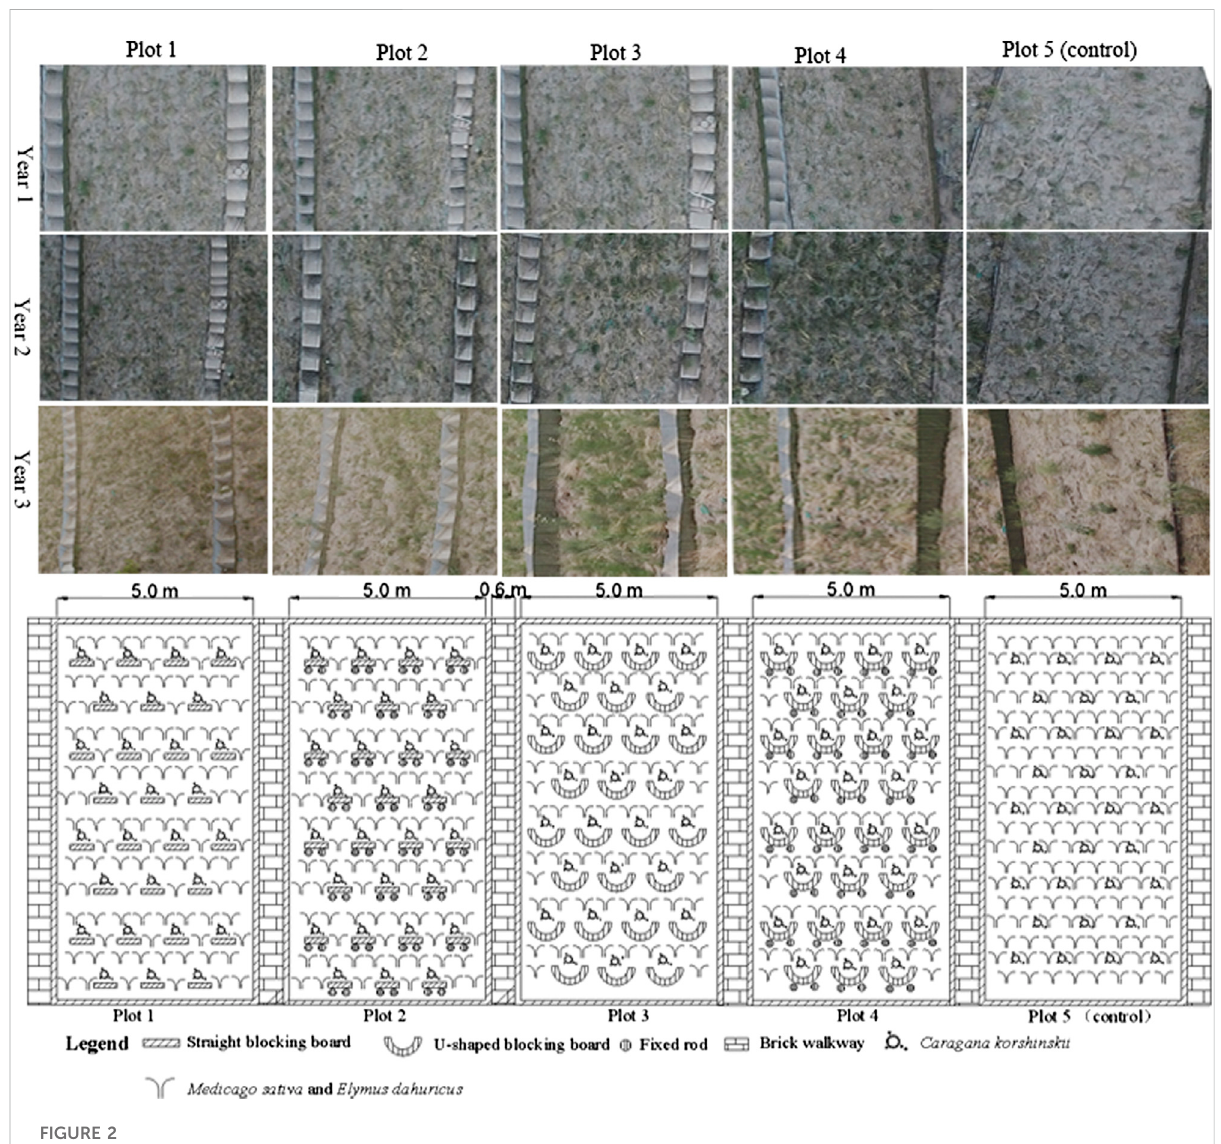
FIGURE 2 Layout map of microtopography modi fi cations in the fi ve